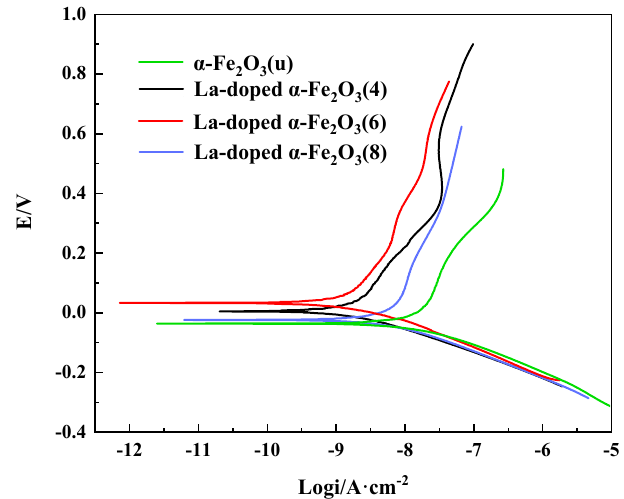
Figure 7. Polarization curves of α -Fe 2 O 3 (u) and La-doped α -Fe 2 O 3 (x) (x = 4, 6, 8).